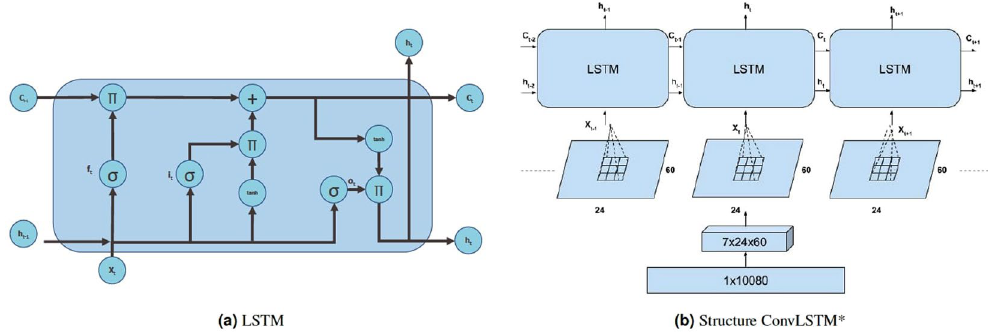
Figure 1. ( a ) Basic LSTM cell. Π denotes multiplication, + denotes addition, σ is sigmoid function, and tanh calculates hyperbolic tangent, ( b ) Transformation and inner structure of ConvLSTM *